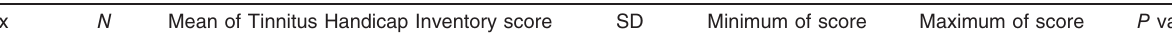
Table 3 Impact of gender on Tinnitus Handicap Inventory score Sex N Mean of Tinnitus Handicap Inventory score